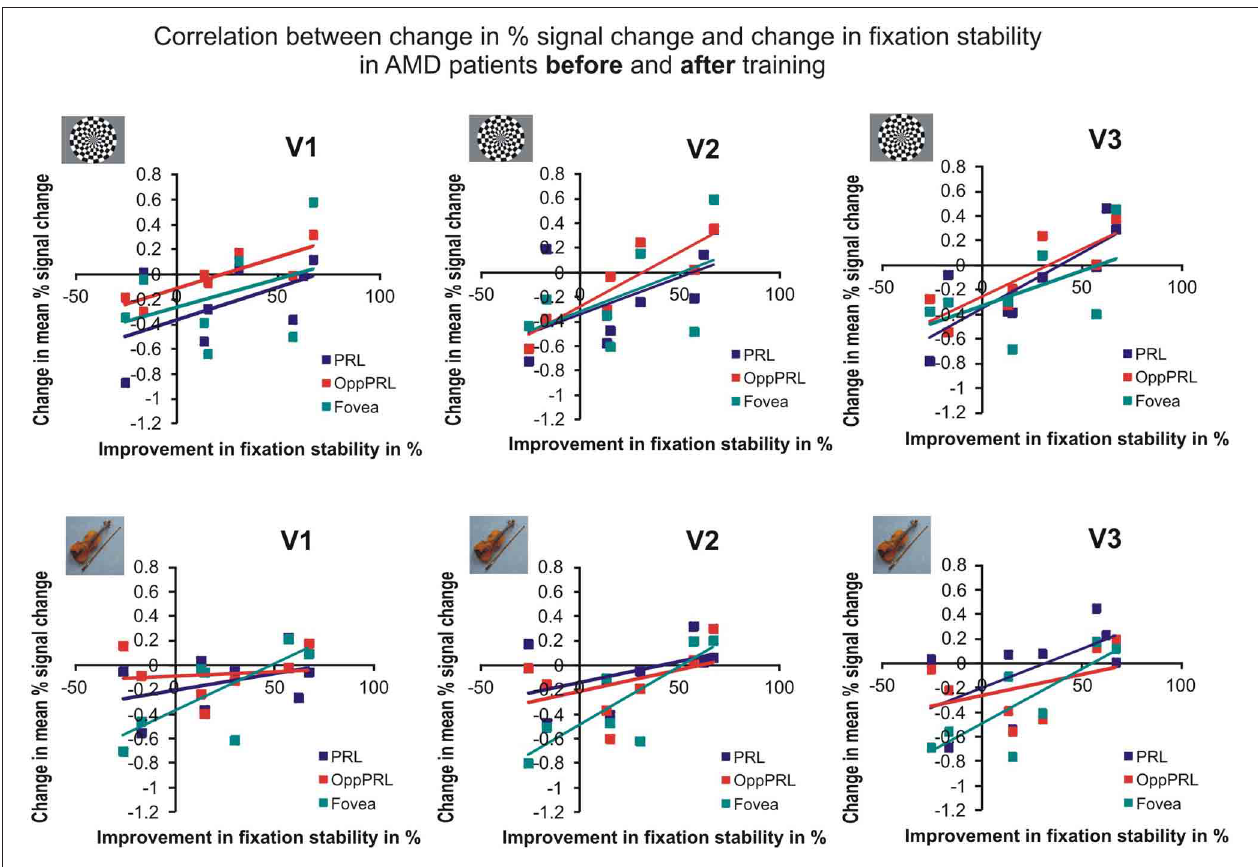
FIGURE 9 | Correlation between the change in % signal change and change in fixation stability for the patient group only before fixation training and after fixation training in individually mapped primary (V1), secondary (V2), and tertiary (V3) visual cortex. The upper row depicts the correlation